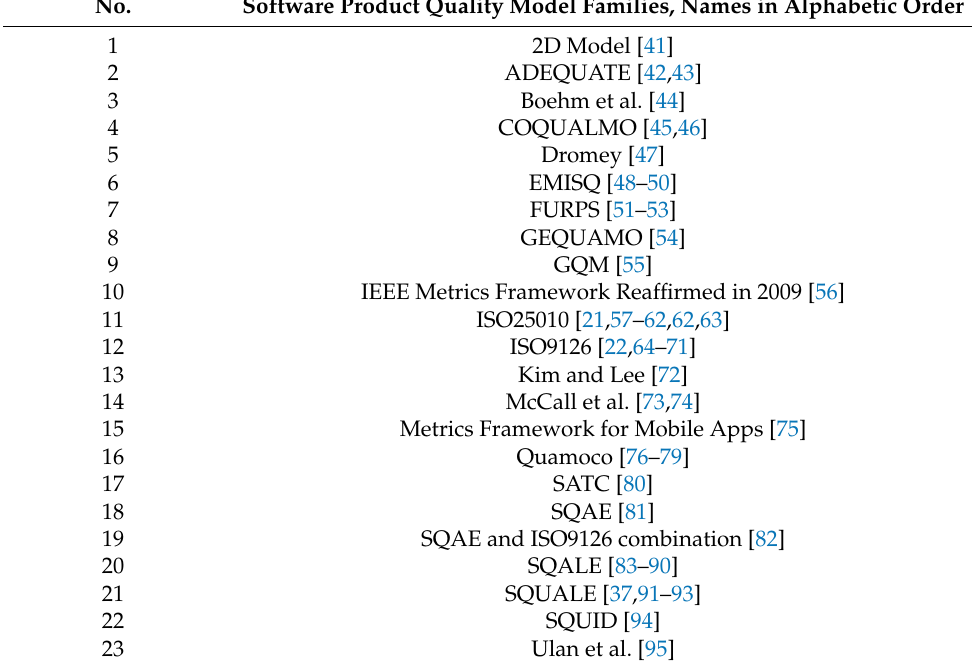
Table 1. Software Product Quality Model Families Defined, Tailored or Referenced in the Last 20 Years